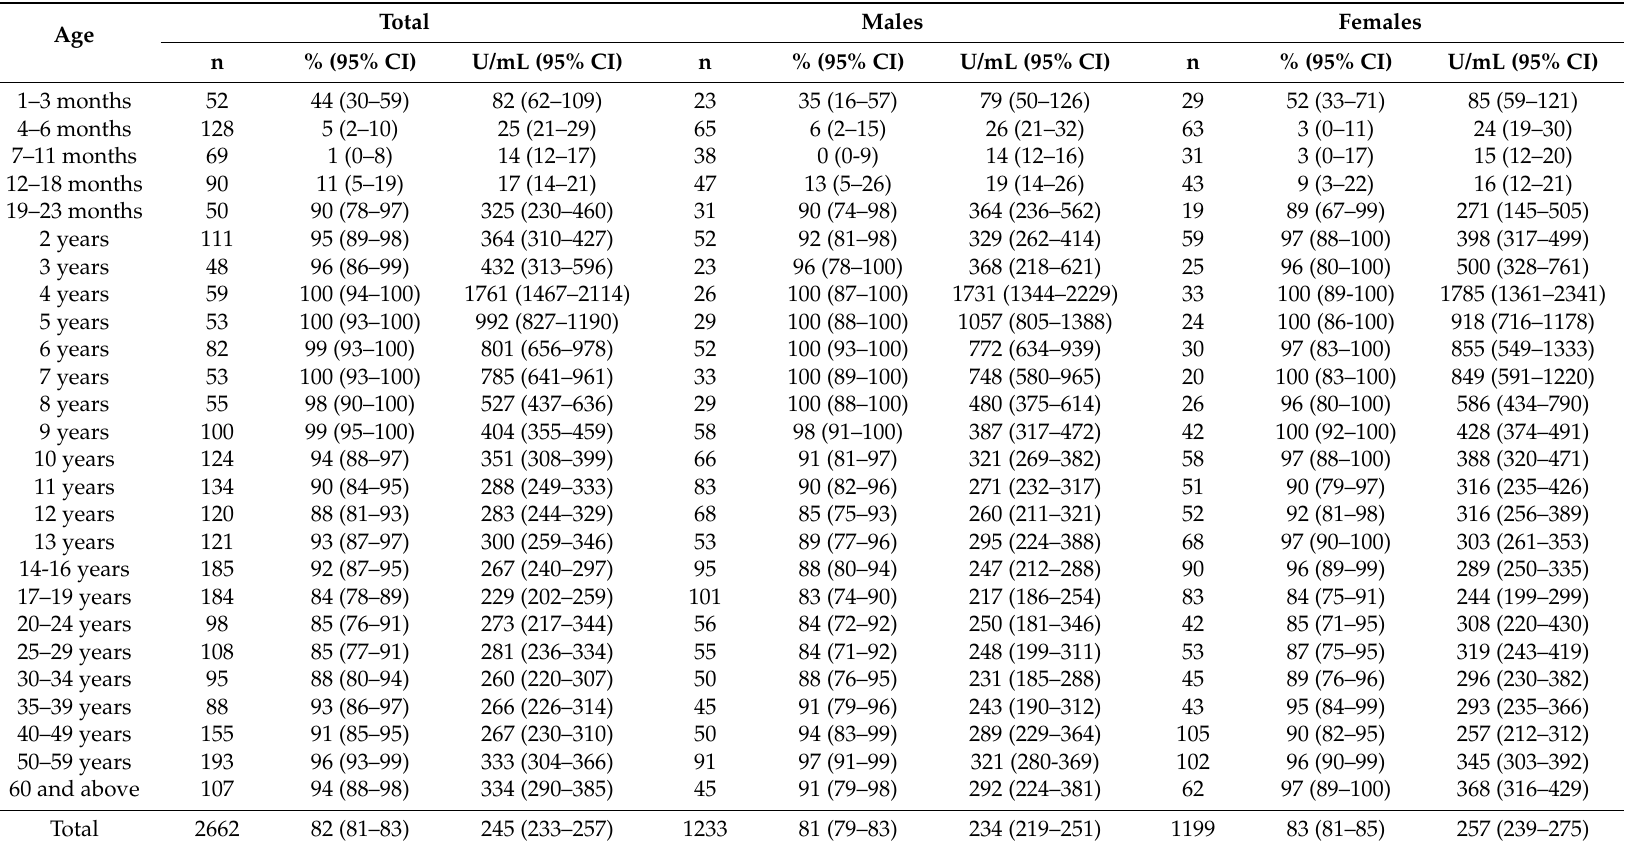
Table 1. Age- and gender-specific mumps IgG seroprevalence (%) and GMC